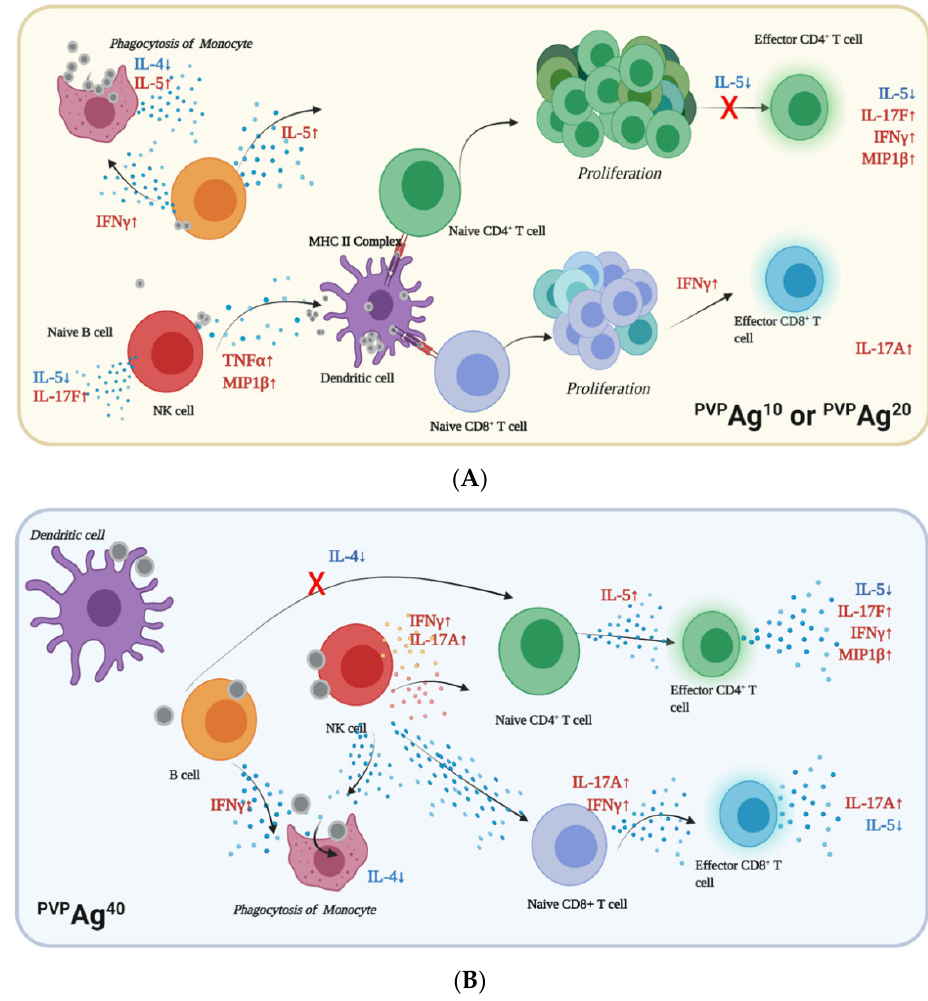
Figure 7. Illustration of immunomodulatory responses of hPBMCs exposed to ( A ) the smaller PVP Ag 10 and PVP Ag 20 and ( B ) the larger PVP Ag 40 .